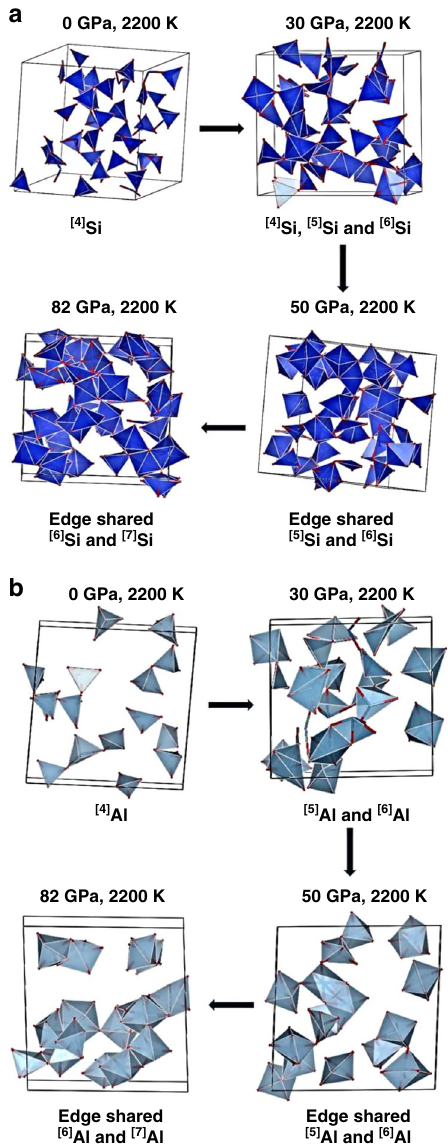
Fig. 5 Si – O and Al – O polyhedra at different pressures. a Depiction of Si – O linkages showing the transition from 0 to 82 GPa via 30 and 50 GPa at 2200 K and b polyhedra of Al – O linkages showing the transition from 0 to 82 GPa via 30 and 50 GPa at 2200 K. [4] Si, [5] Si, [6] Si, and [7] Si are the four, fi ve, six, and sevenfold coordinated Si atoms. [4] Al, [5] Al, [6] Al and [7] Al are the four, fi ve, six, and sevenfold coordinated Al atoms. The fi gures are not drawn to